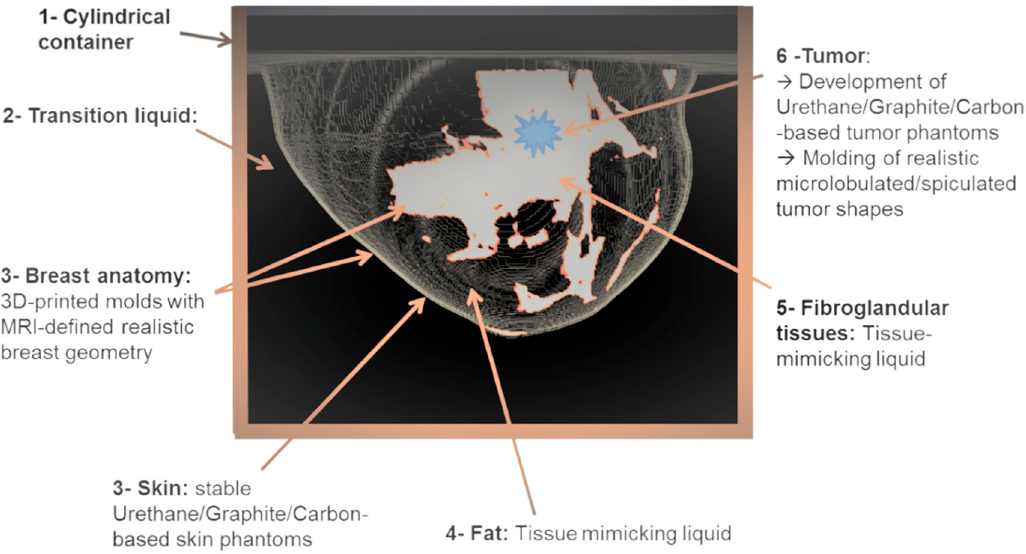
Figure 7. Realistic modeling of the near-field, non-planar, multi-layer, high permittivity transmission medium for electromagnetic wave penetration.